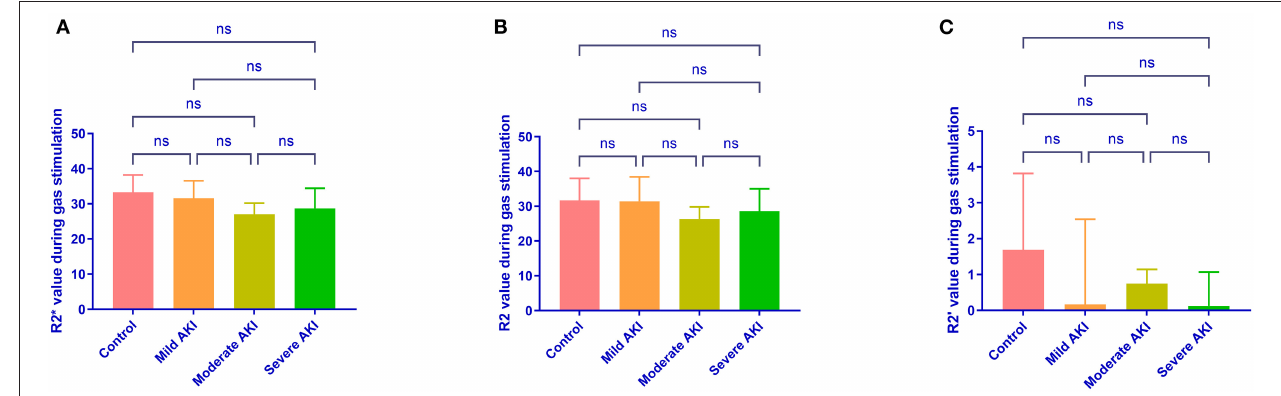
FIGURE 5 | R2*, R2, and R2’ values during carbogen in different groups. Differences are not identified in R2* (A) , R2 (B) and R2’ (C) values during carbogen among different groups. ns, not significant.